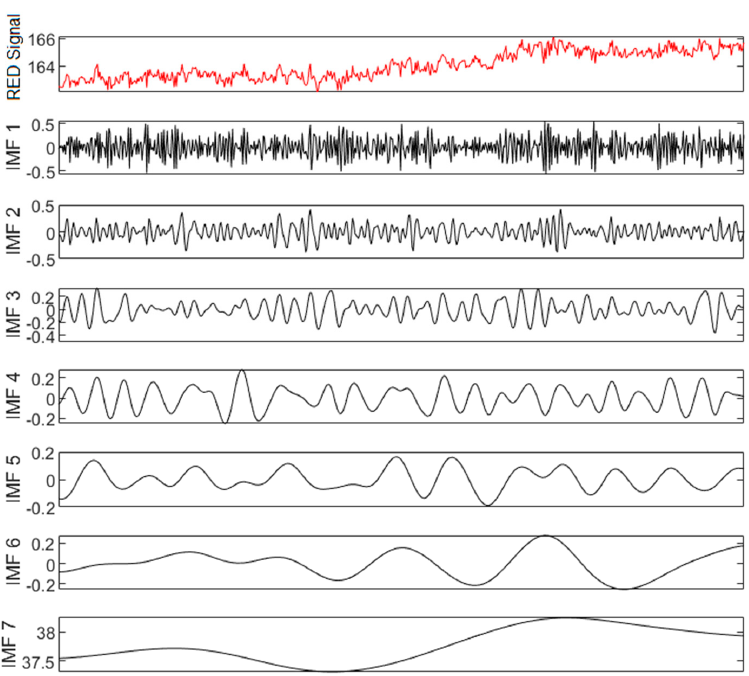
Figure 6. Signal decomposition of i R ( t ) using a complete EEMD technique with 100 realisations and 100 iterations with 0.2 noise standard deviation.